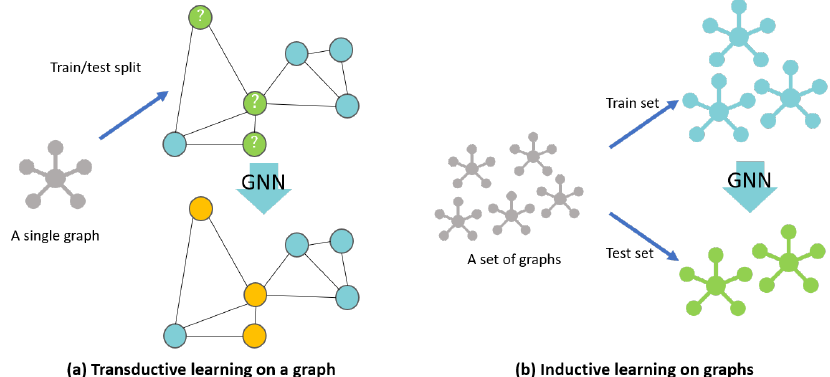
Figure 3. Node classification on a transductive learning GNN method ( a ) and on an inductive learning GNN method ( b ). In the transductive learning method, ( a ) the model is trained by accessing all the nodes and edges in order to predict the class of nodes in the test set (denoted by question marks). In the inductive learning method ( b ), on the other hand, the set of graphs is split into training and test set, and the test set is predicted with a GNN model trained on a set of training